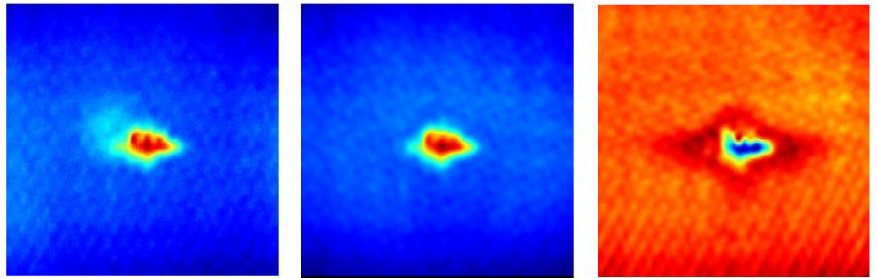
Figure 13. Thermographic images of the front face of panel 10: thermographic image ( left-hand side ), TSR image ( centre ), and second derivative ( right-hand side